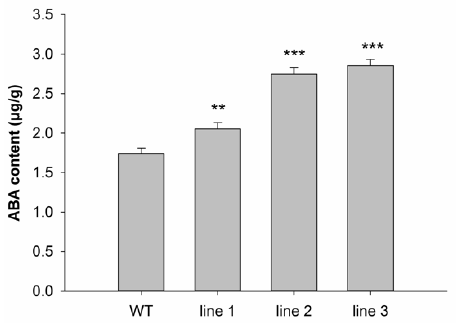
Figure 4. ABA content of WT and transgenic alfalfa. Data were expressed as mean ± SE (n ≥ 6). WT: wild-type alfalfa; line 1, 2, 3: transgenic alfalfa. ** and *** indicates a statistically significant difference at p < 0.01 and p < 0.001, respectively.